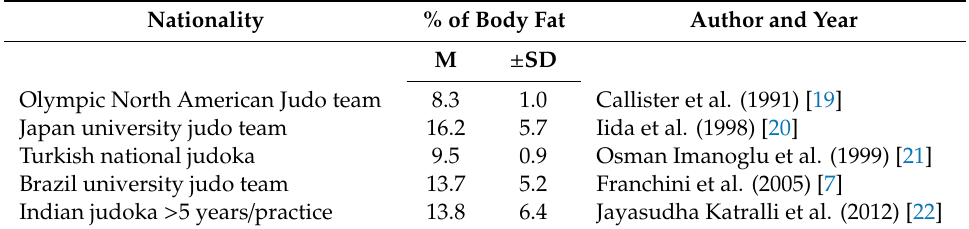
Table 1. Percentage of body fat (mean M and standard deviation ± SD) of national and university teams according to the measurements of di ff erent authors and